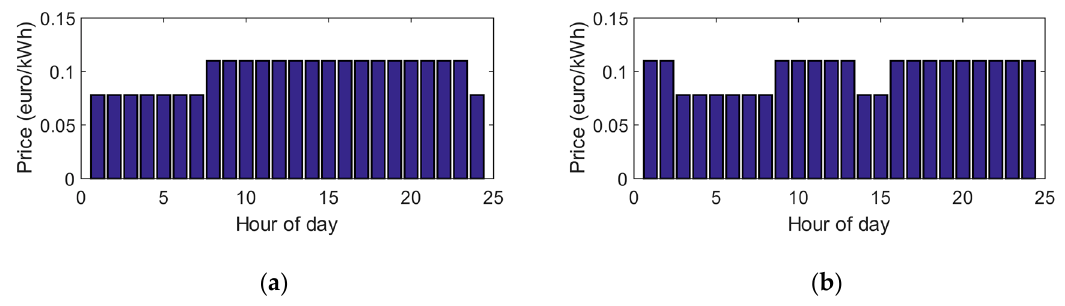
Figure 1. ToU tariffs: ( a ) spring and summer tariff; ( b ) autumn and winter tariff.